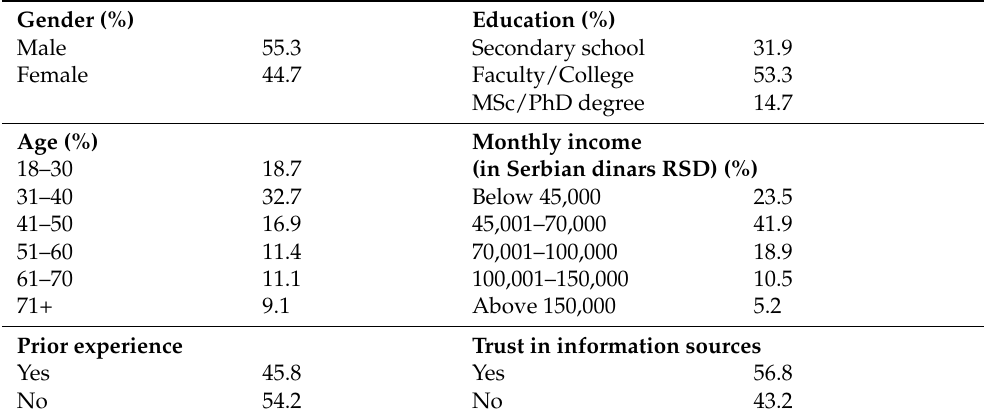
Table 1. The sample characteristics (N =